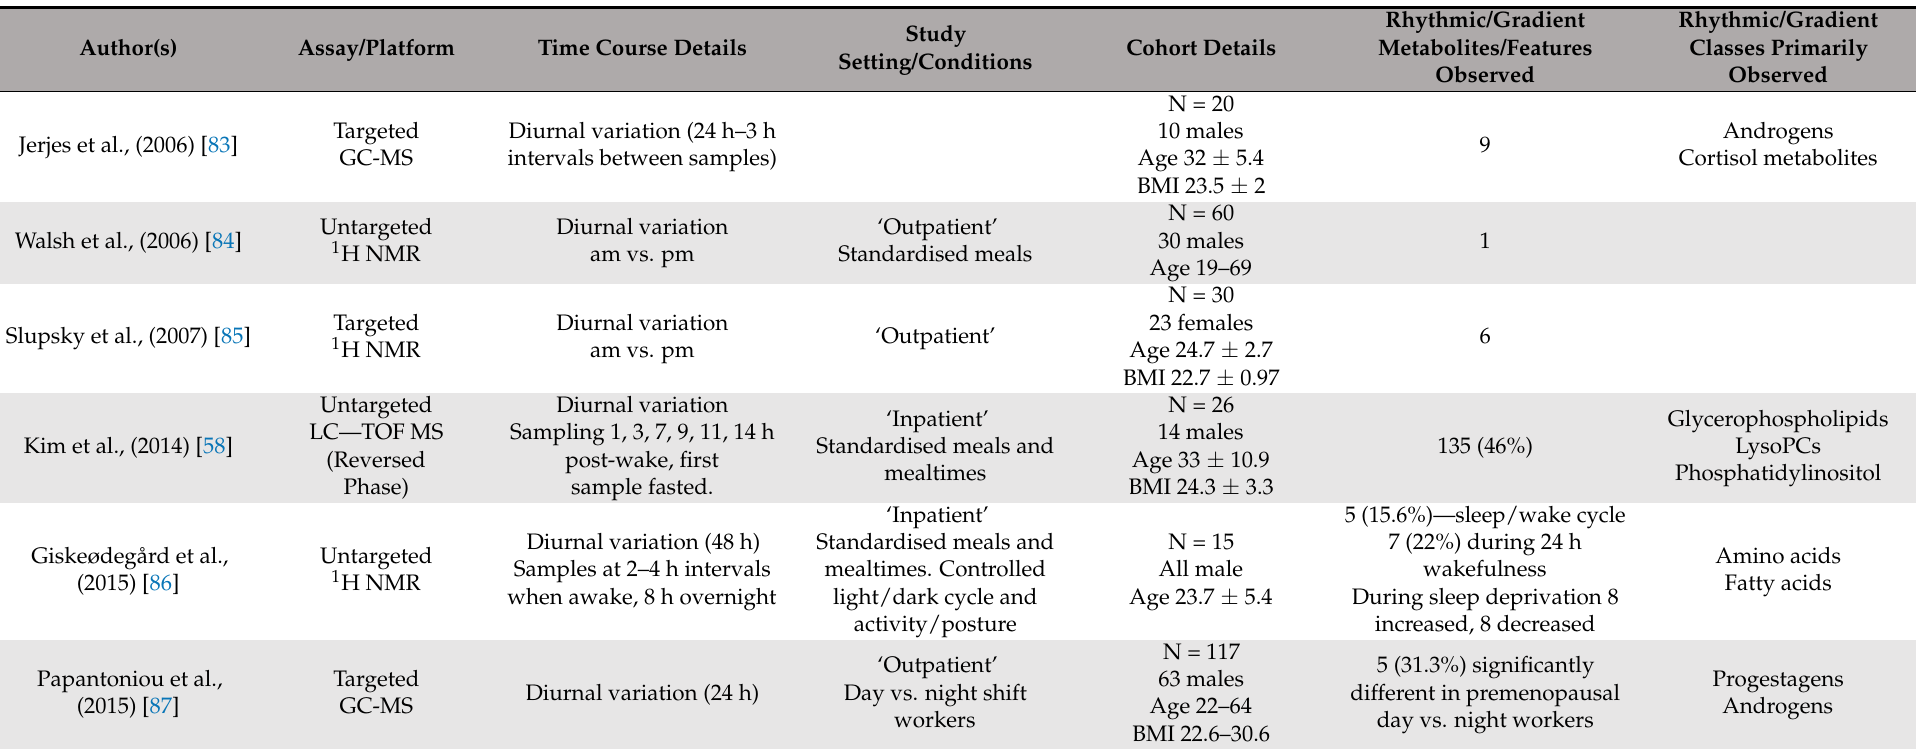
Table 3. A brief summary of study design, cohort details and results with regard to observed time of day variation of metabolites for relevant studies analysing